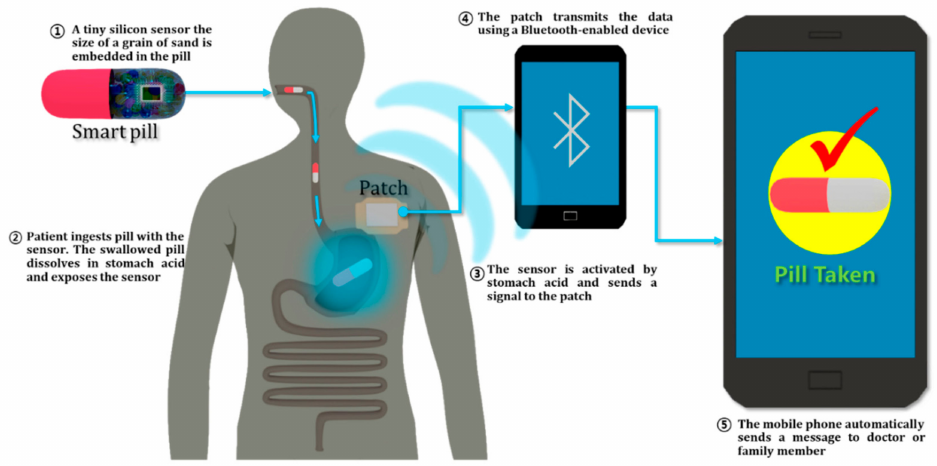
Figure 7. Overview of ingestible pill sensor